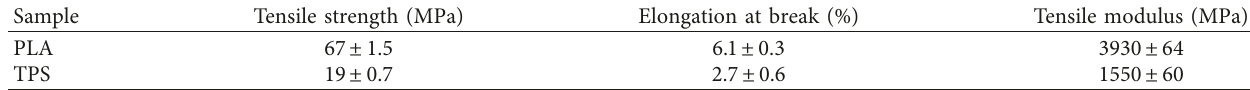
Table 1: Characteristics of PLA and